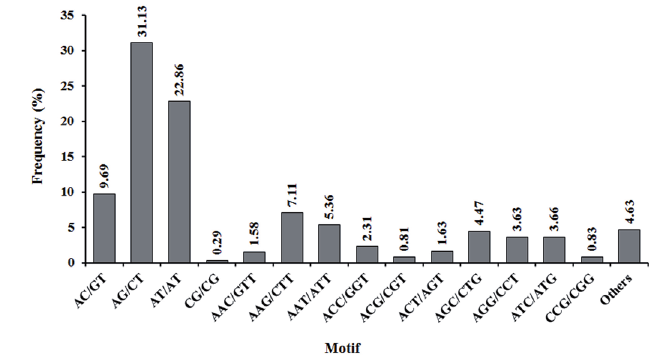
Fig. 2: Frequency distribution of cSSRs according to sequence motifs. A total 81 sequence motifs were identified. Di-, tri- and other (including tetra-, penta- and hexa-) nucleotide repeats were present in 4, 10, and 67 types,